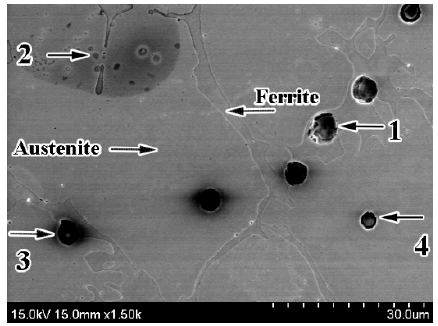
Figure 6. The SEM micrographs of the oxides and MnS phases in the HAZ of GTAW weldments. Table 3. EDS compositional analysis (wt %) of the oxides and MnS phases in the HAZ of GTAW weldments.